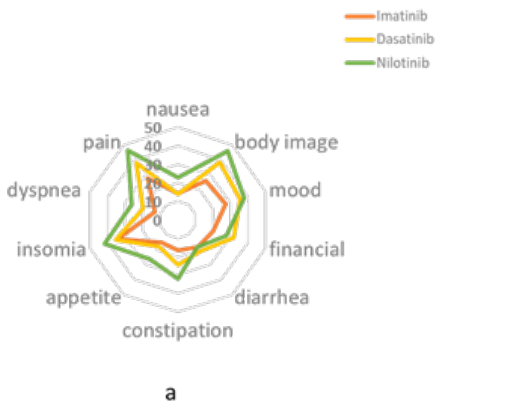
Figure 2. Functional Status on imatinib vs. dasatinib and nilotinib. Functional status according to QLQ30 and CML-24 in patients on imatinib, dasatinib or nilotinib. ( a ). A polar plot summarizes scores of 5 different aspects of function according to patient reports. Social function is represented in 2 scales (QLQ30 and CML-24). As shown, patients on imatinib are represented in the outer circle, indicating better function. ( b ). A bar graph showing that patients on imatinib report higher levels of emotional functioning. European Organization for Research and Treatment of Cancer Quality of Life Core Questioner 30 (EORTC QLQ-C30); European Organization for Research and Treatment of Cancer Quality of Life Questioner of Chronic myeloid Leukemia 24 (EORTC QLQ-CML24). 3.4. Additional Health-Related (HR) Items In addition to the EORTC questionnaires, several items were added by us and are analyzed herein (Table 3). Table 3. Patients’ reported outcomes—additional questions.